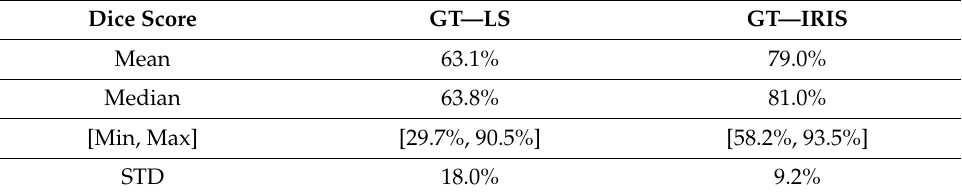
Table 2. Compared dice scores of LS and IRIS against GT. GT = ground truth segmentation, LS = automatic level set segmentation, IRIS = intelligent rapid interactive segmentation, and STD = standard deviation.